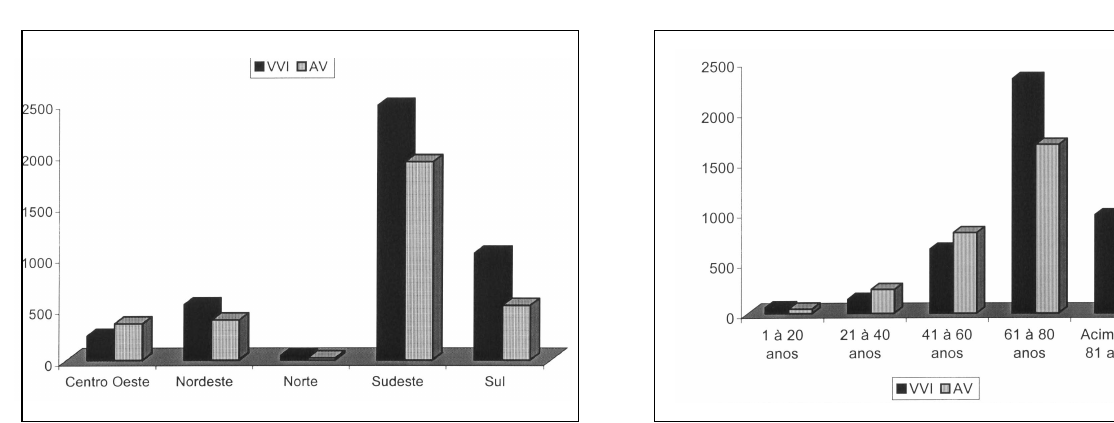
Fig. 6 - Modos de estimulação utilizados nos implantes iniciais, agru- pados segundo a faixa etária dos